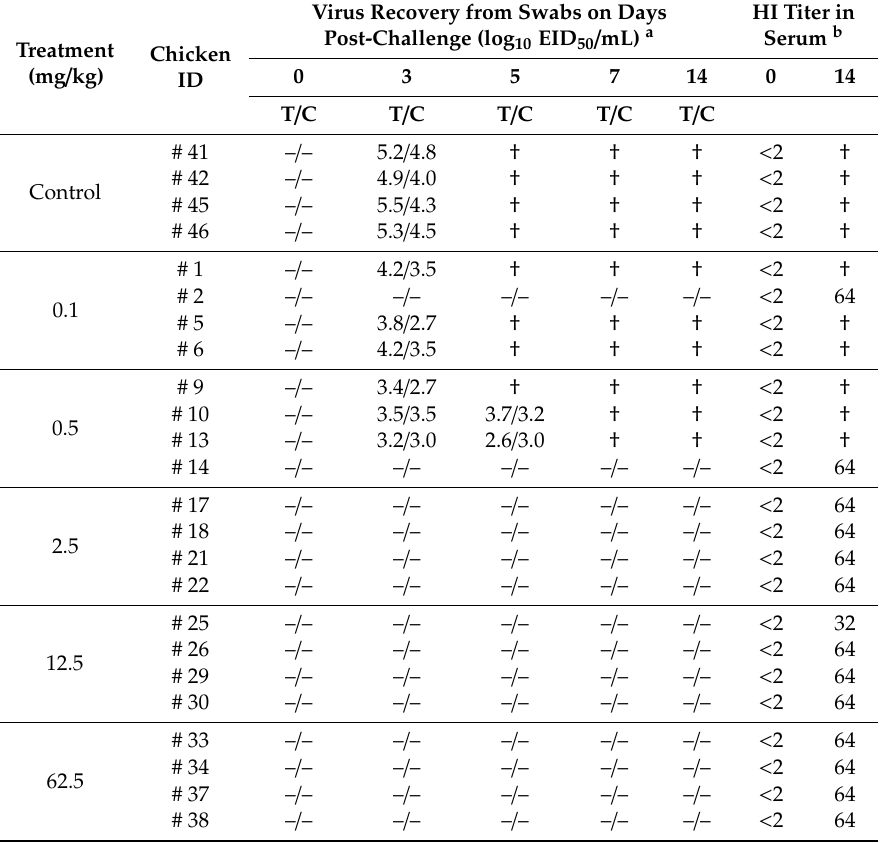
Table 1. Virus recovery in tracheal and cloacal swabs and antibody response in the serum of the chickens treated with di ff erent doses of BXM at single